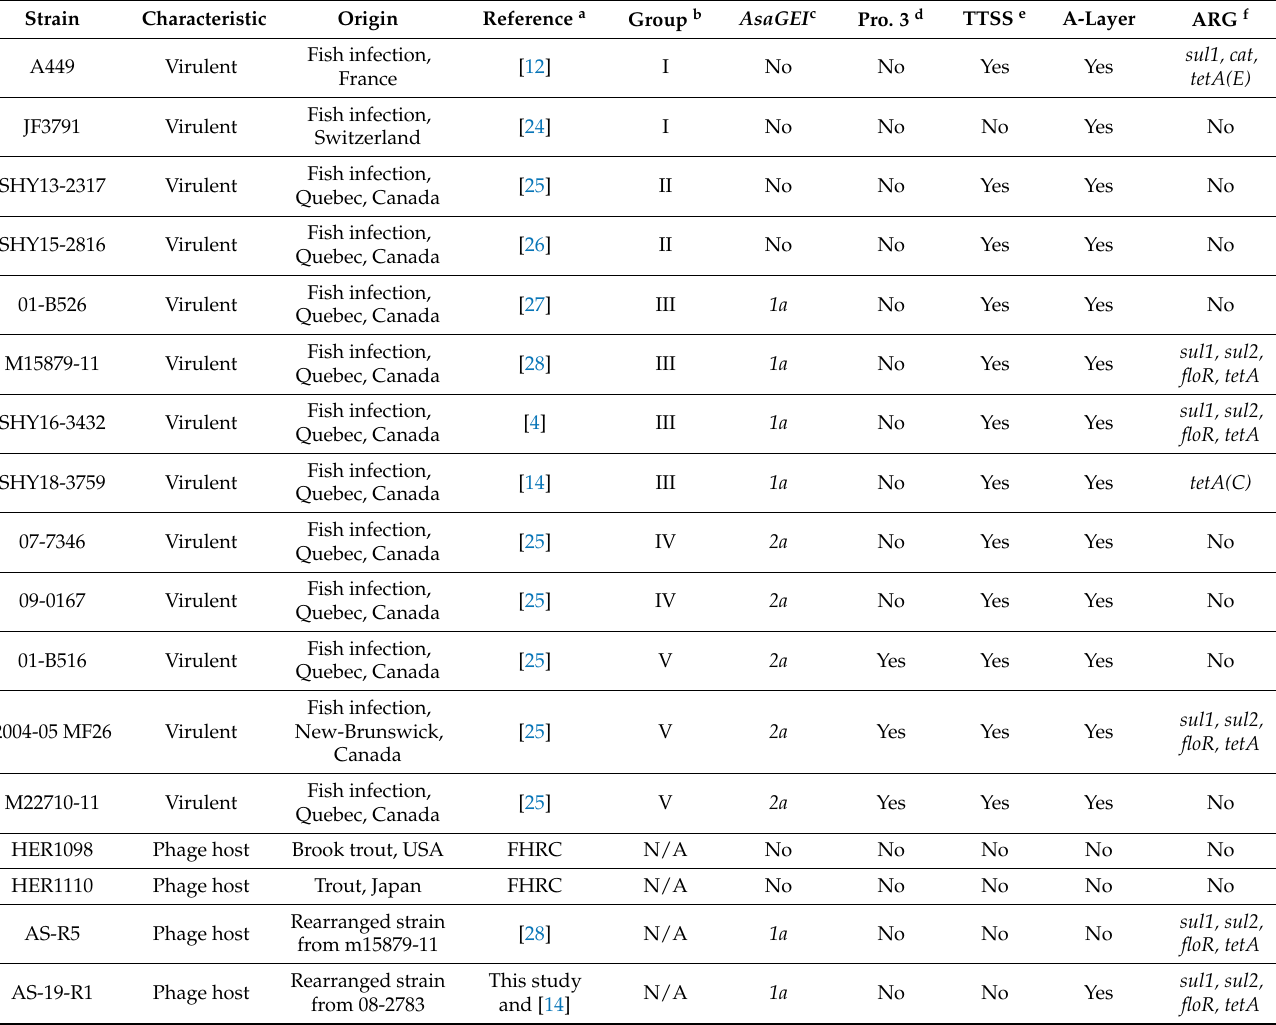
Table 1. A. salmonicida subsp. salmonicida strains used in this study.